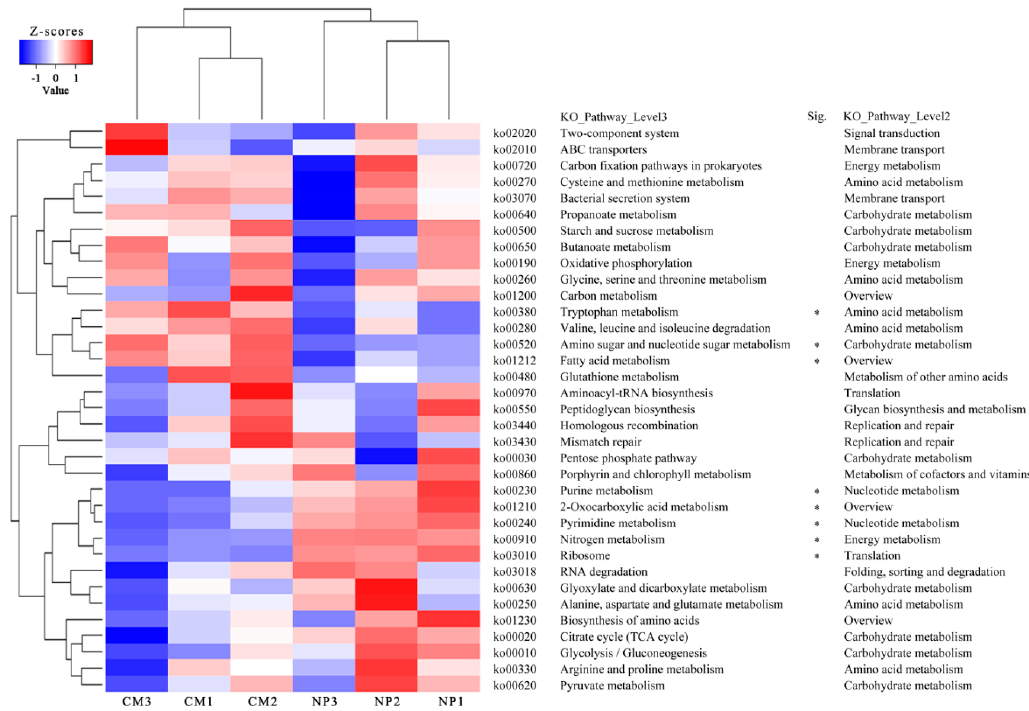
Figure 5. Heat map analysis of the top 35 most abundant KEGG pathways in at least one soil sample using normalized abundance. Heat map is color-coded based on row z-scores. The metabolic pathways assigned to “Organismal Systems” and “Human Diseases” on KEGG database were excluded. NP and CM represent the one-year cultured soil and two-year consecutively monocultured soil, respectively. Sig. represents significant differences for level 3 KEGG pathways between two different treatments (* q <